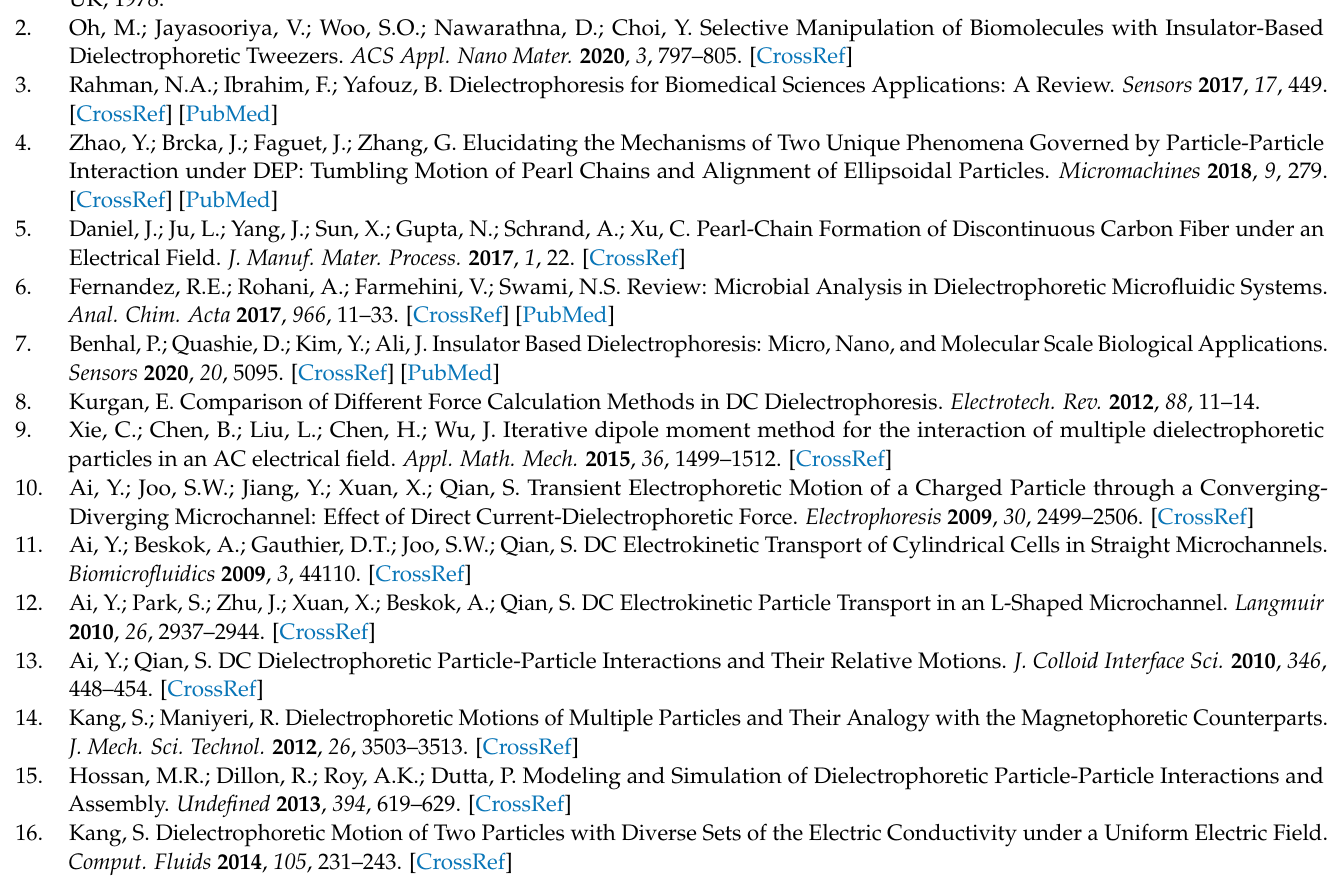
chitecture; Figure S2: Training progress showing the validation accuracy of AlexNet; Figure S3: Confusion matrix of AlexNet; Figure S4: Training progress showing the validation accuracy of VGG19. Figure S5: Confusion matrix of VGG19; Figure S6: Training progress showing the validation accuracy of MobileNetV2; Figure S7: Confusion matrix of MobileNetV2; Table S1: Performance result of MobileNetV2 on adversarial samples using 7v Dataset; Table S2: Performance result of MobileNetV2 on adversarial samples using 5v Dataset; Table S3: Performance result of MobileNetV2 on adversarial samples using 3v